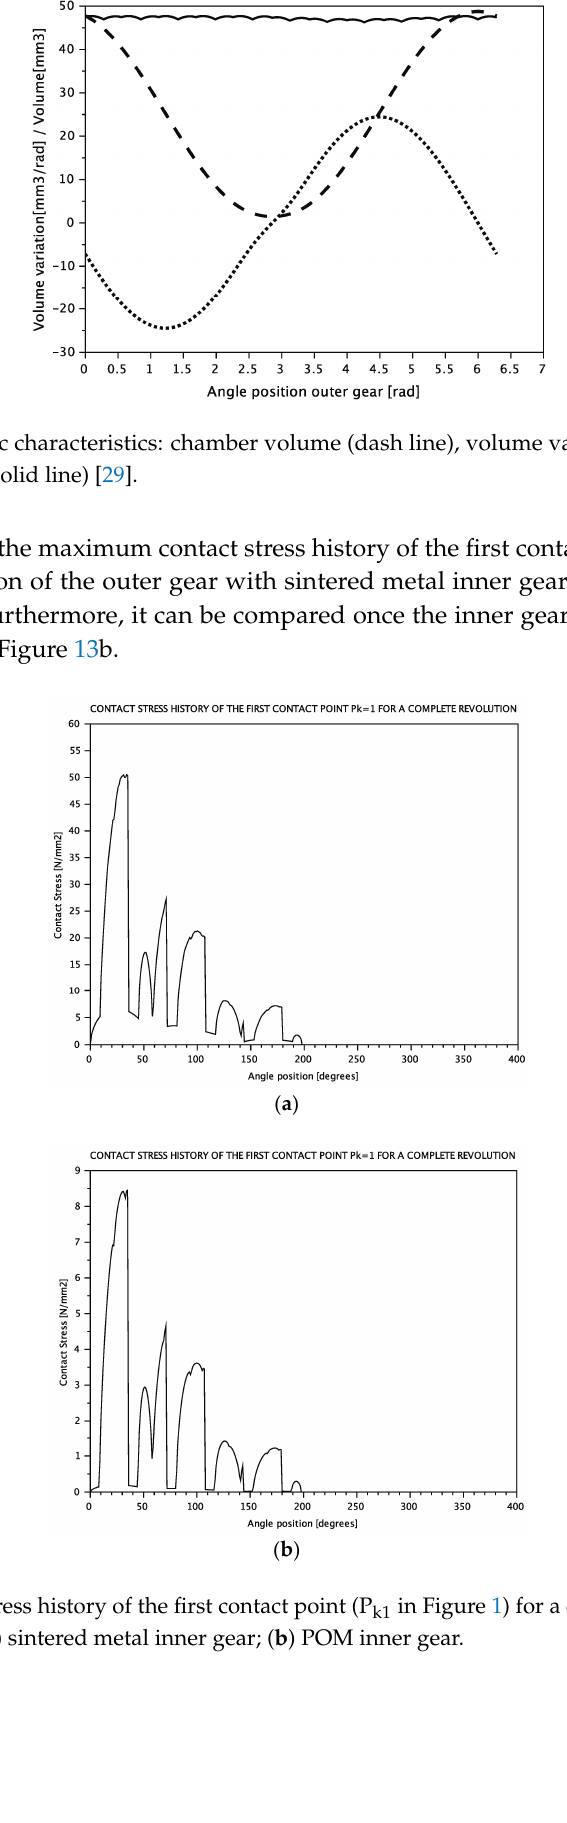
12 of 19 Figure 11. In-house mini test bench structure. 4. Results and Discussion 4.1. Mini Trochoidal-Gear Theoretical Fluid-Mechanical Characteristics Fluid-mechanical characteristics are analytically simulated by means of GeroLAB Package System [29] under certain working conditions. Performance indexes such as the volumetric characteristics (chamber volume, volume variation, instantaneous flow, and irregularity flow index, as the rate between the difference of maximum-minimum volume and the average volume) and the